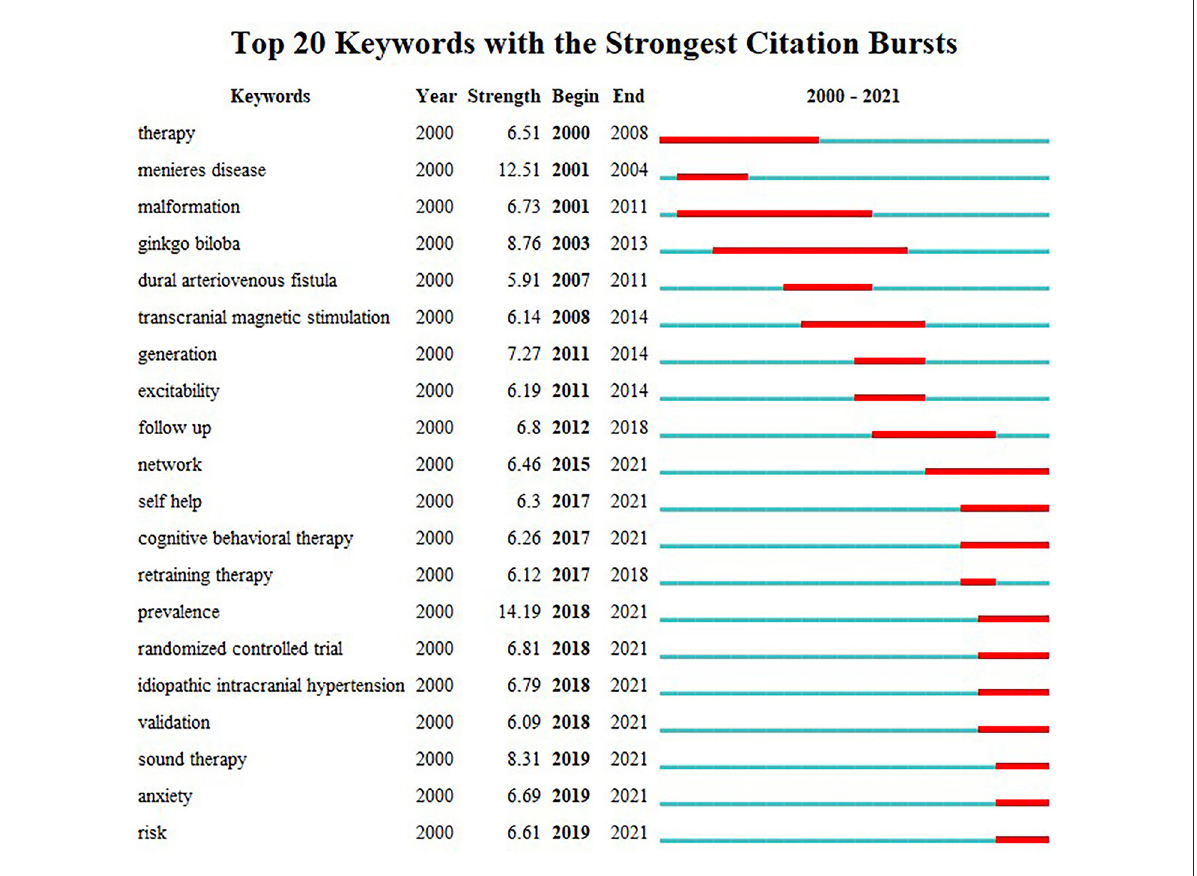
FIGURE9 The top 20 burst words for tinnitus